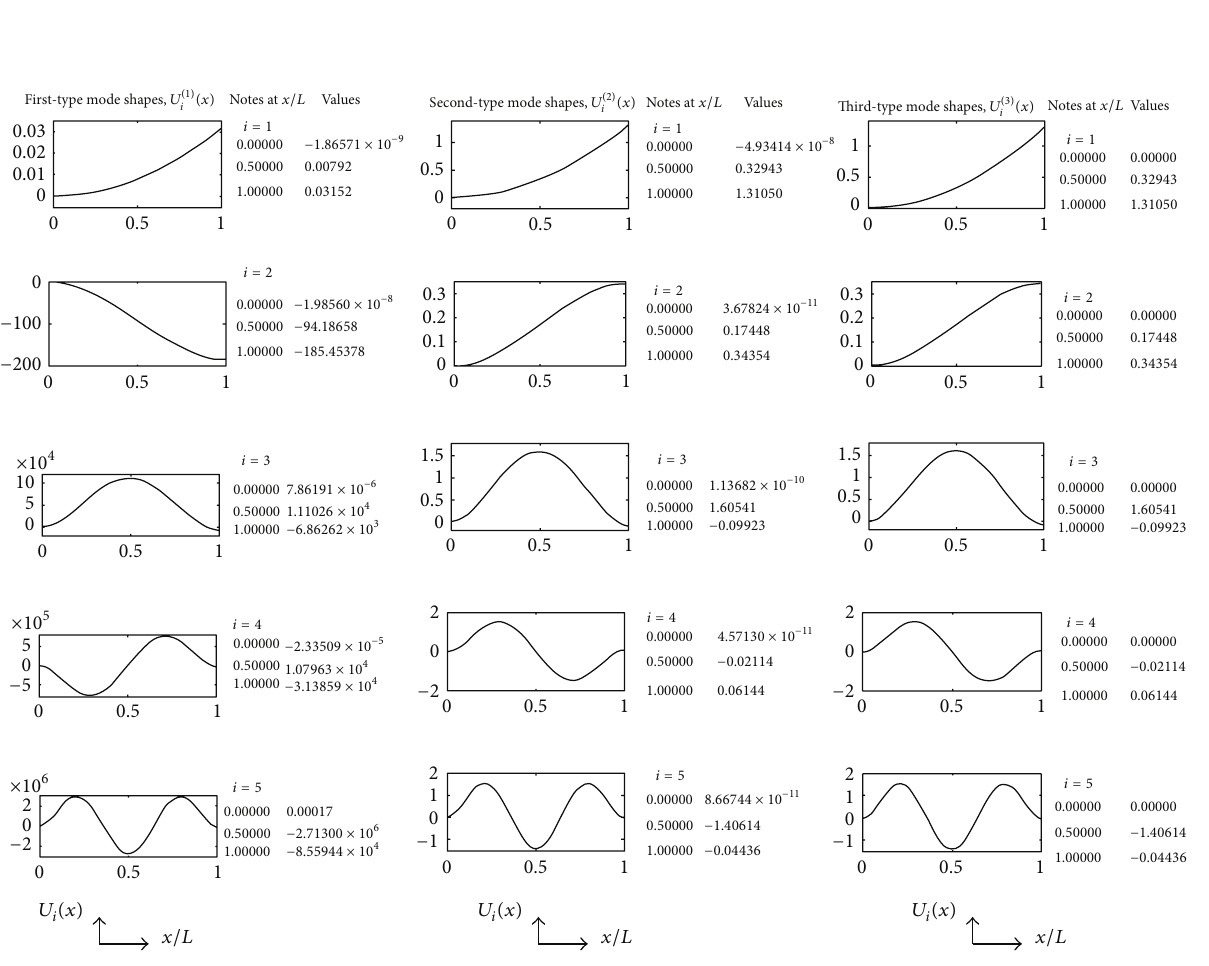
Figure 4: Three types of the first five mode shapes with the combinations of 𝜙 = 4 , 𝑘/𝐿 = 4 , and 𝑑/𝐿 = 0